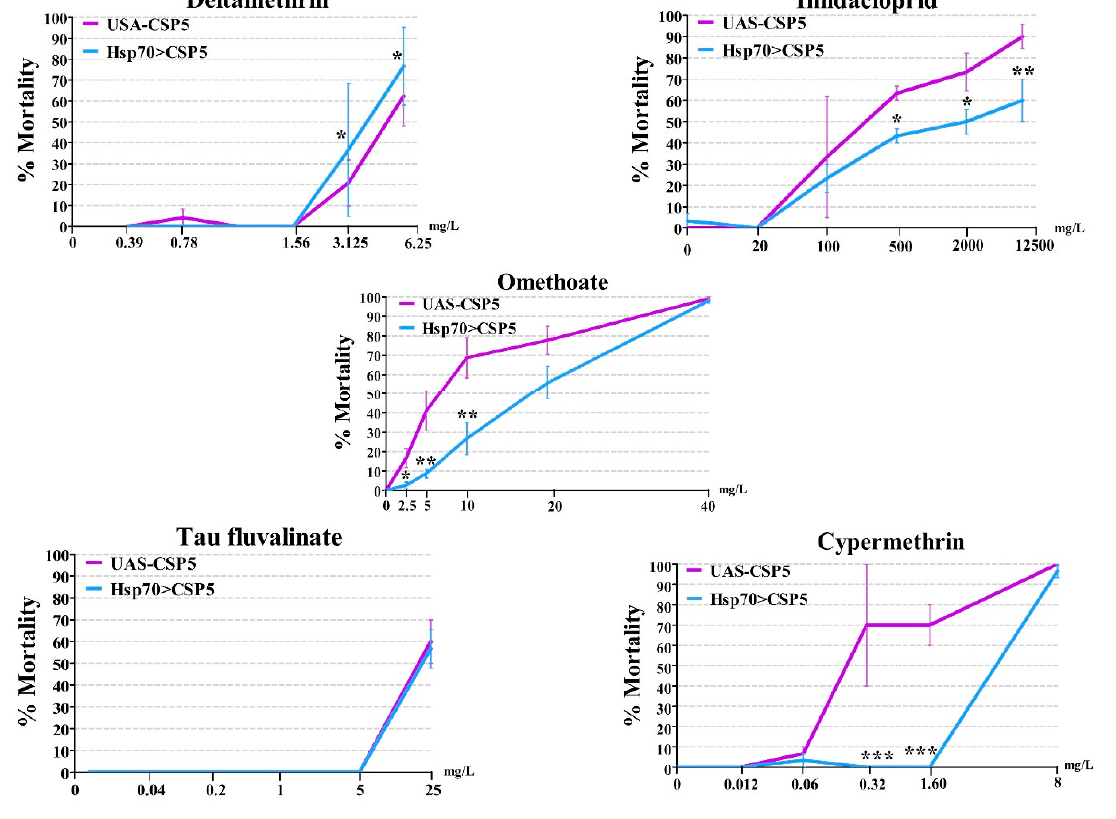
Figure 4. AgosCSP5 reduction of the susceptibility of the transgenic Drosophila flies to insecticides. The mortalities were compared between the transgenic line ( Hsp70 – GAL4 > UAS – CSP5 with heat shock) and control line ( Hsp70 – GAL4 > UAS – empty with heat shock) exposed to different doses of insecticides. *, ** and *** represent p < 0.01, p < 0.001 and p < 0.0001 significant differences.